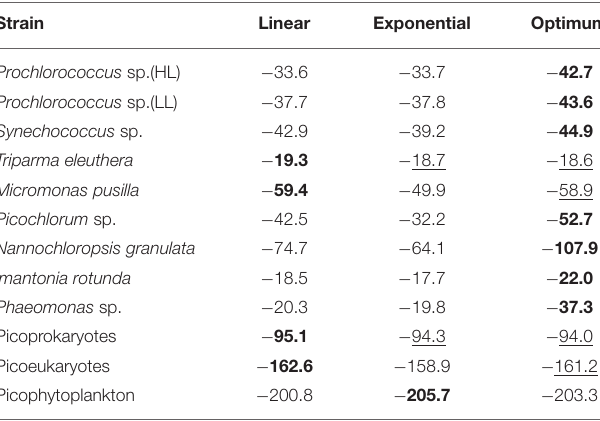
TABLE 2 | AIC values for the linear, exponential and optimum fits for individual picophytoplankton strains, both groups of picoprokaryotes and picoeukaryotes, and picophytoplankton.